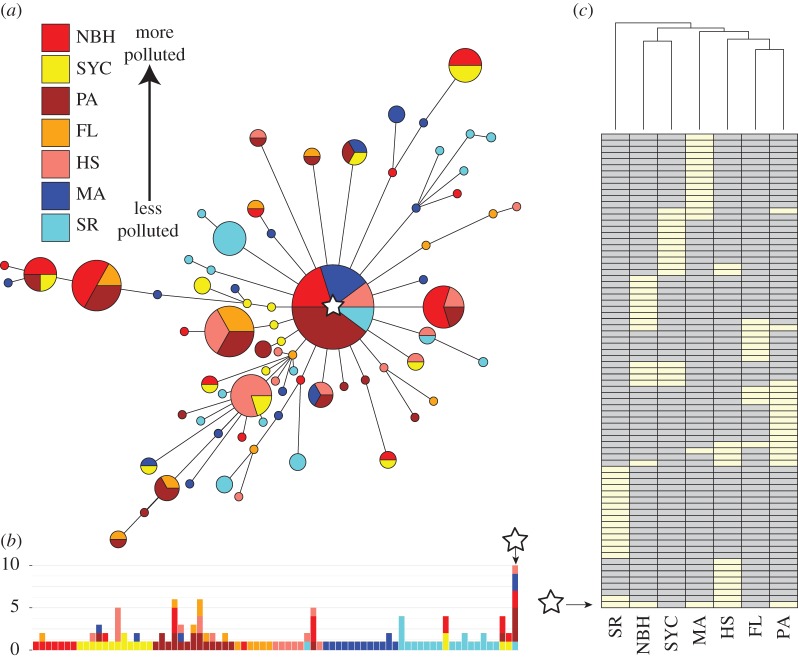
(a) Maximum-parsimony haplotype network considering all haplotypes in the sample. (b) Distribution of haplotypes among all 133 samples. The abscissa represents each of the 77 haplotypes in the sample. The stacked bars represent the number of individuals showing that particular haplotype colour-coded by population. (c) Shared haplotype matrix. Each row in the matrix represents each of the 77 haplotypes. Light/dark boxes represent the presence/absence of that haplotype in a particular population. In all cases, the star indicates the most common haplotype.